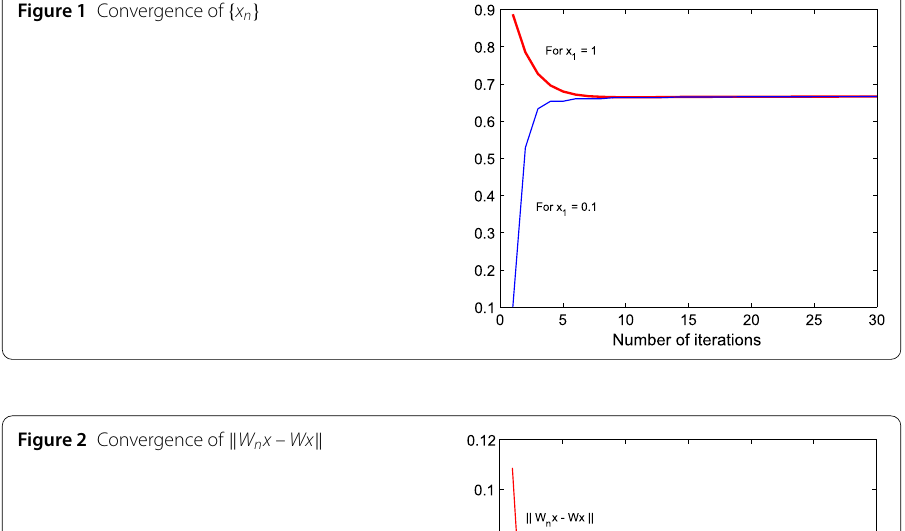
Figure 1 Convergence of { x n }